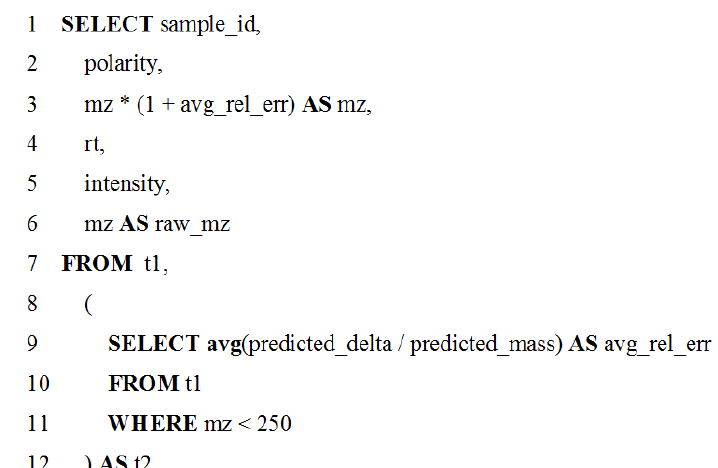
Figure 4. Example query utilizing the Query Tabular tool for a metabolomics data analysis workflow. The two part SQL query corrects mass errors in low resolution MS-based metabolomics data, using an inner- and outer-query. The inner-query (lines 9–11) determine the average mass error for mz values of detected molecules below 250 Daltons. The outer-query (all other lines) adjusts all mz values in this range based on the determined mass error. Chromatographic retention time (rt) and signal intensities are also assigned values for the molecules detected by